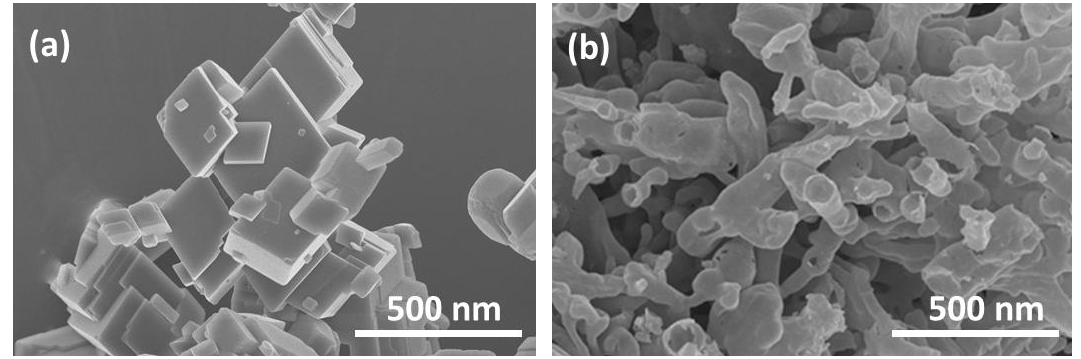
Figure 2. SEM images of ( a ) CaCO 3 nanocubes and ( b ) CaCO 3 nanorods.